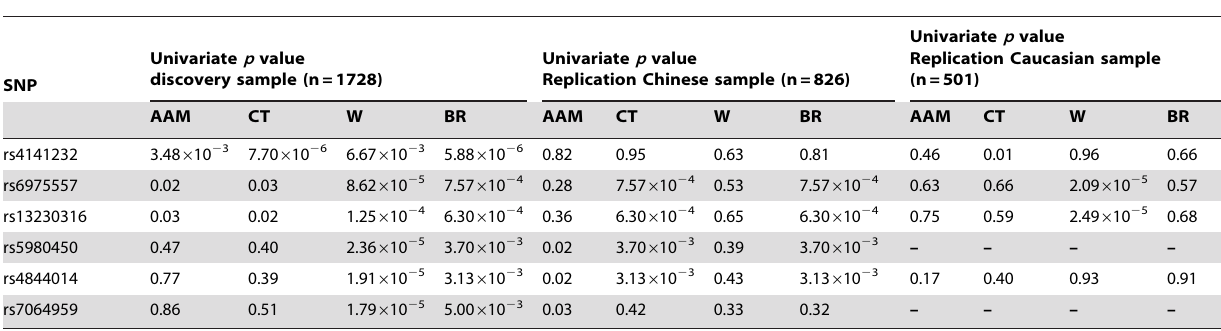
Table 5. Results of univariate association analyses for the six SNPs in the discovery sample and the replication samples.